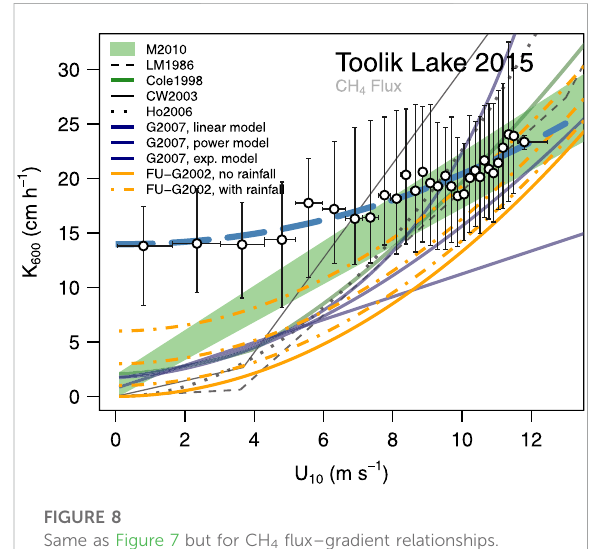
FIGURE 8 Same as Figure 7 but for CH 4 fl ux – gradient